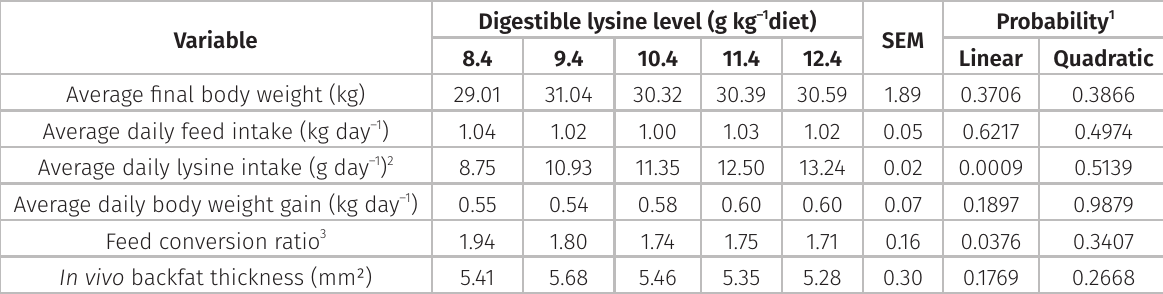
Table II. Effect of digestible lysine level on growth performance characteristics of barrows in the starter phase (15 to 30